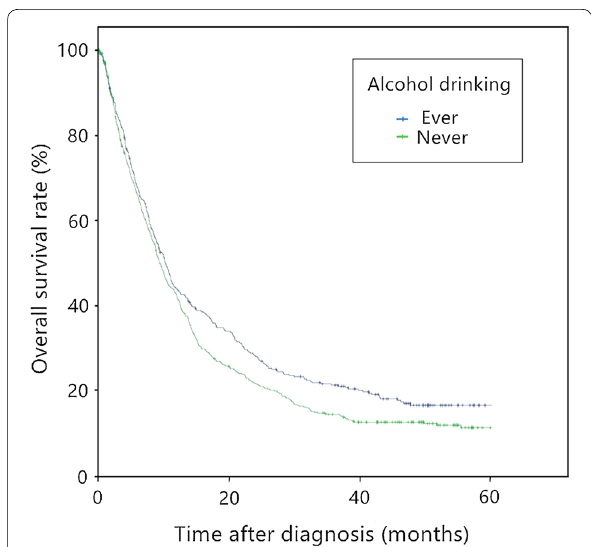
Fig. 1 Kaplan–Meier survival curves for Chinese men with lung cancer, grouped by level of alcohol consumption. Patients who ever regularly consumed alcohol before being diagnosed with lung can‑ cer had a better prognosis than those who never consumed alcohol